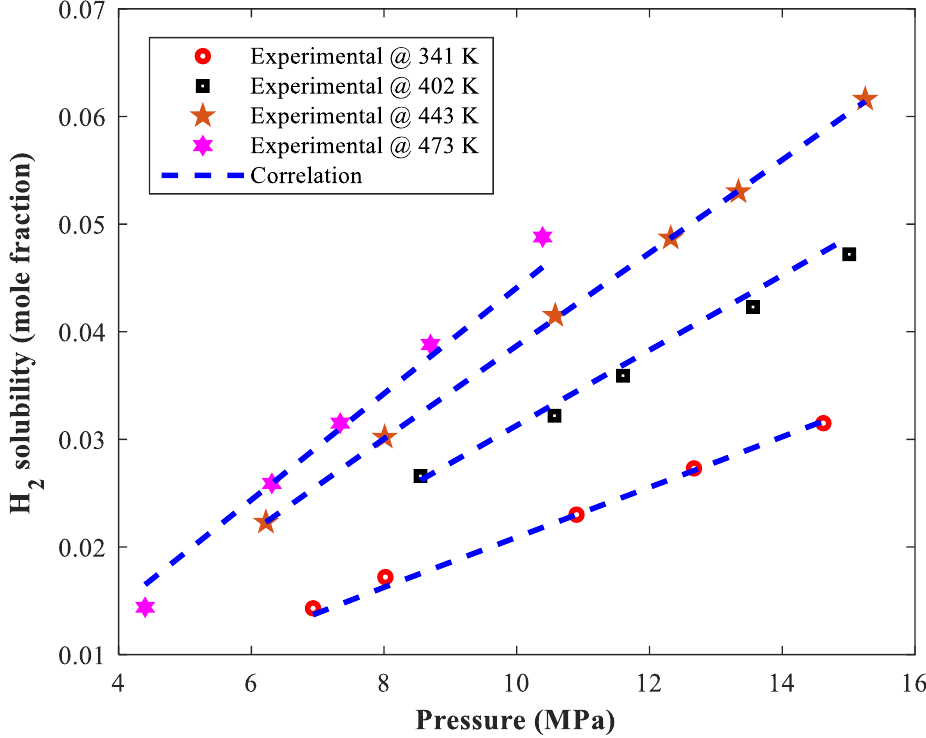
Figure 7. Impact of isothermal variation of pressure on H 2 dissolution in the allyl alcohol.